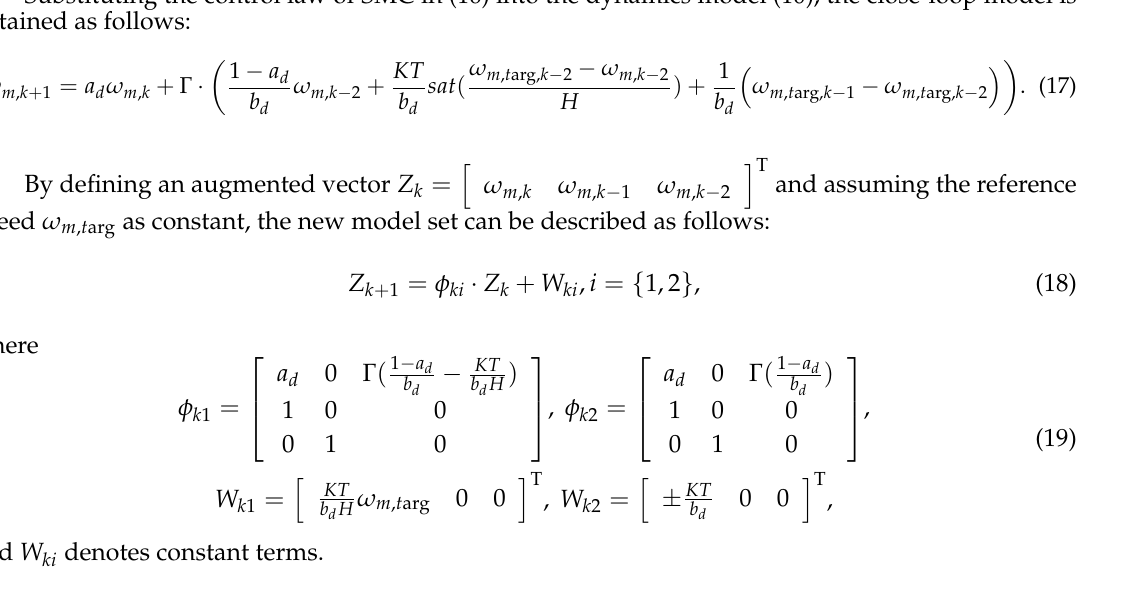
Figure 4. System pole map: ( a ) Eigenvalues of the system matrix φ k 1 ; and ( b ) Eigenvalues of the system matrix φ k 2